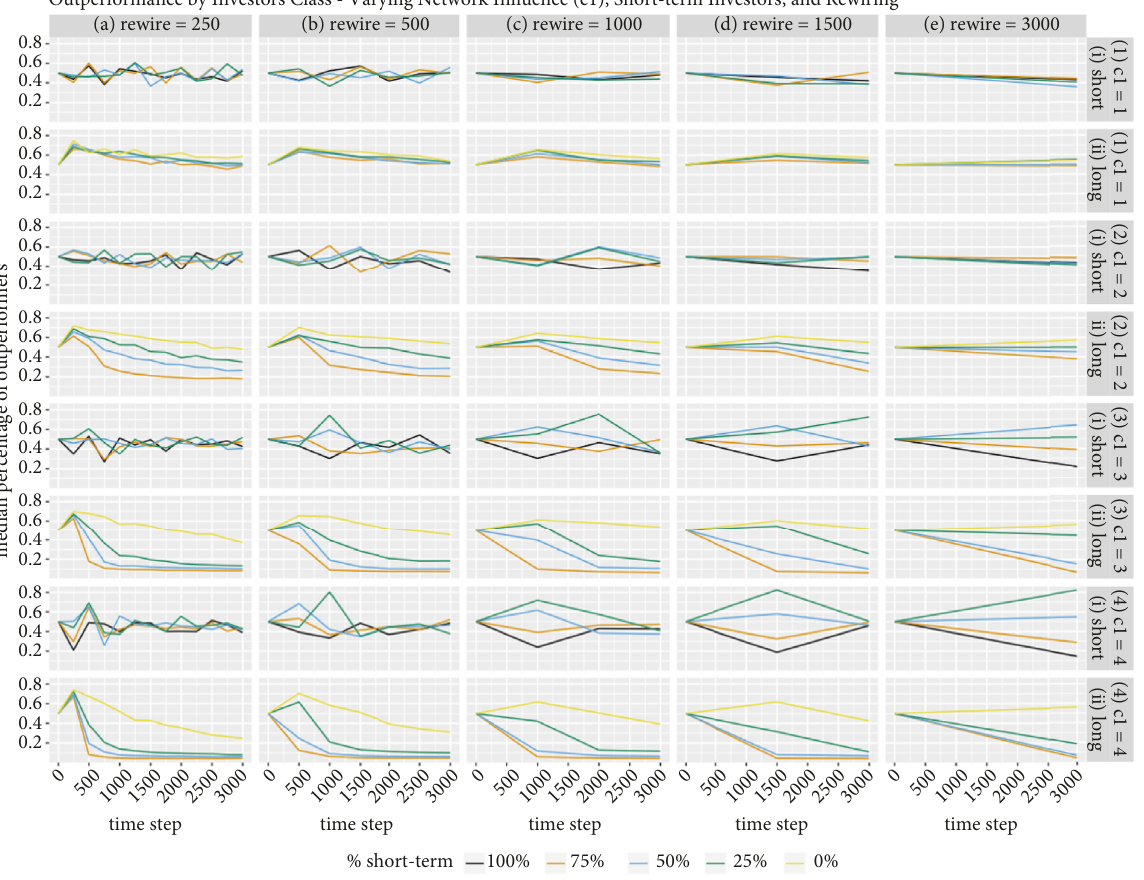
Figure 11: Proportion of outperformers within each investor subclass. Facets now differentiate for the rewiring and c 1 variables and the investor subclasses. The lines represent the temporal evolution of the proportion of outperformers for the various combination of short- and long-term investors. Short-term investors appear to exhibit superior